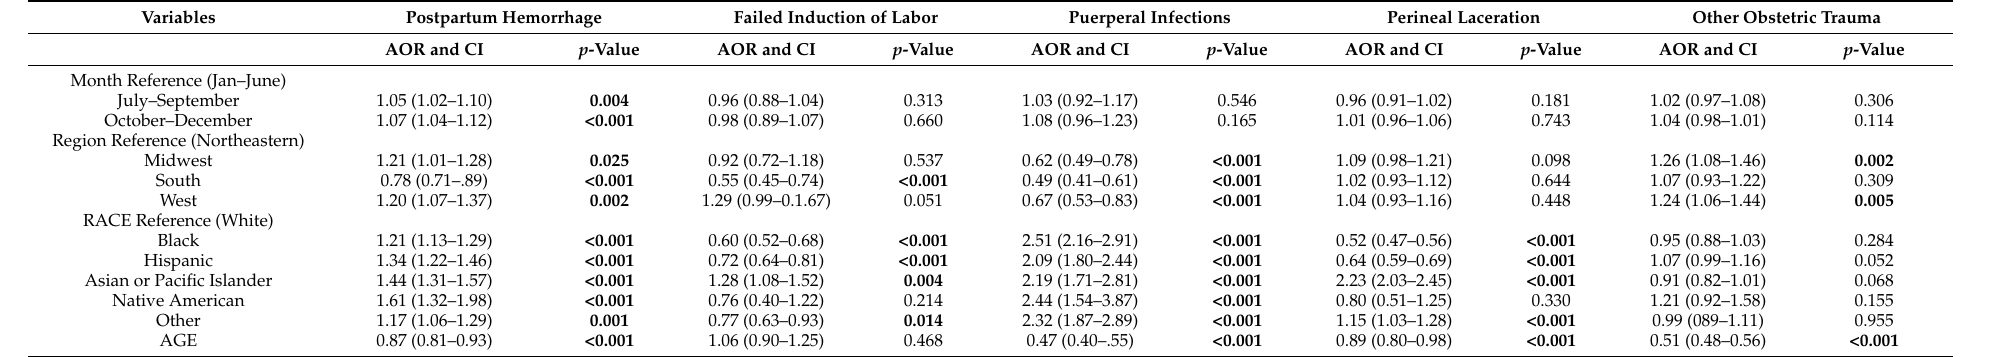
Table 1. Logistic regression of Postpartum Hemorrhage and Factors Increased PPH Risk across the U.S. Regions and Hospital Characteristics.